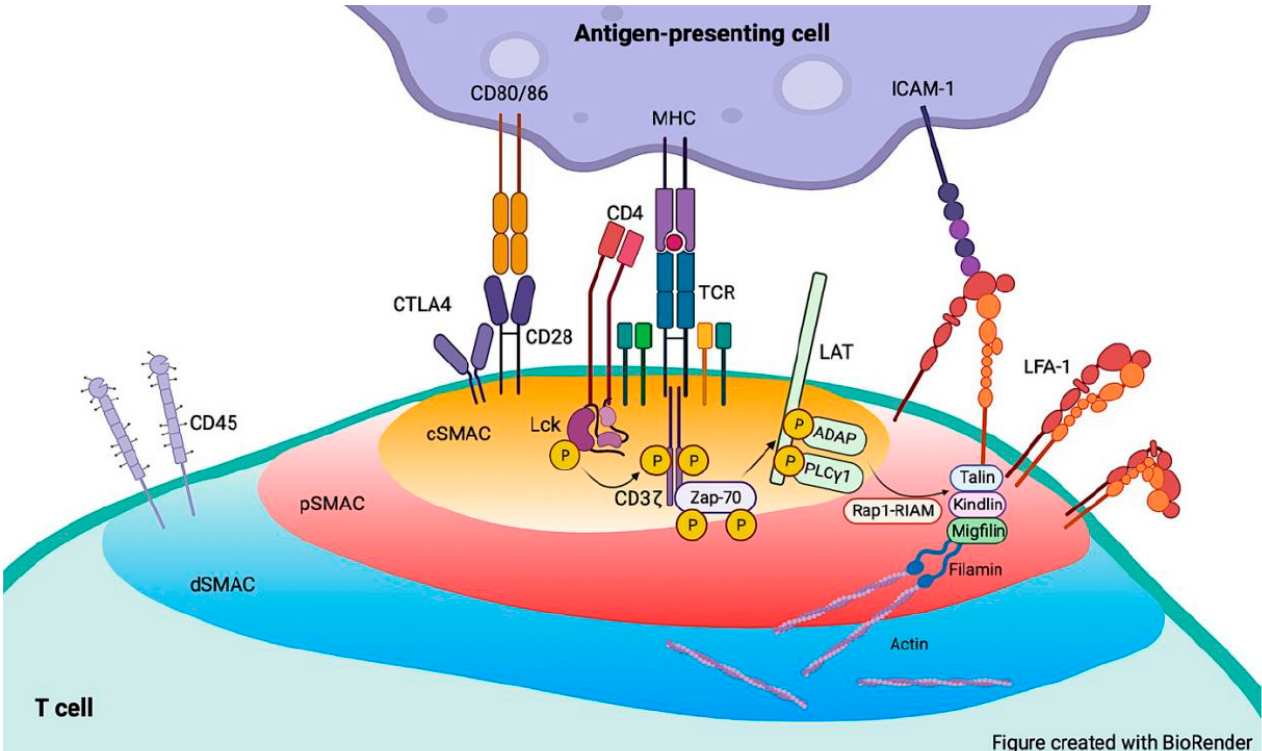
Figure 3. Role of LFA-1 in the immune synapse formed between antigen-presenting cells and T cells. The immune synapse is characterized by different compartments: central, peripheral, and distal supramolecular activation clusters. T-cell receptors (TCR) and associated signaling molecules are in the central supramolecular activation cluster (cSMAC). The peripheral supramolecular activation cluster (pSMAC) is an outer ring rich in LFA-1 and talin1. The distal supramolecular activation cluster (dSMAC) contains CD45 and F-actin. LFA-1, leukocyte function-associated antigen 1; ICAM-1, intercellular adhesion molecule 1; CTLA4, cytotoxic T lymphocyte antigen 4; Zap-70, ζ -chain-associated protein 70; LAT, linker for activation of T cells; MHC, major histocompatibility complex; Lck, lymphocyte-specific protein tyrosine kinase; ADAP, adapter protein; PLC γ 1, phospholipase C γ 1; Rap1, Ras-related protein 1; RIAM, Rap1-GTP-interacting adaptor molecule.